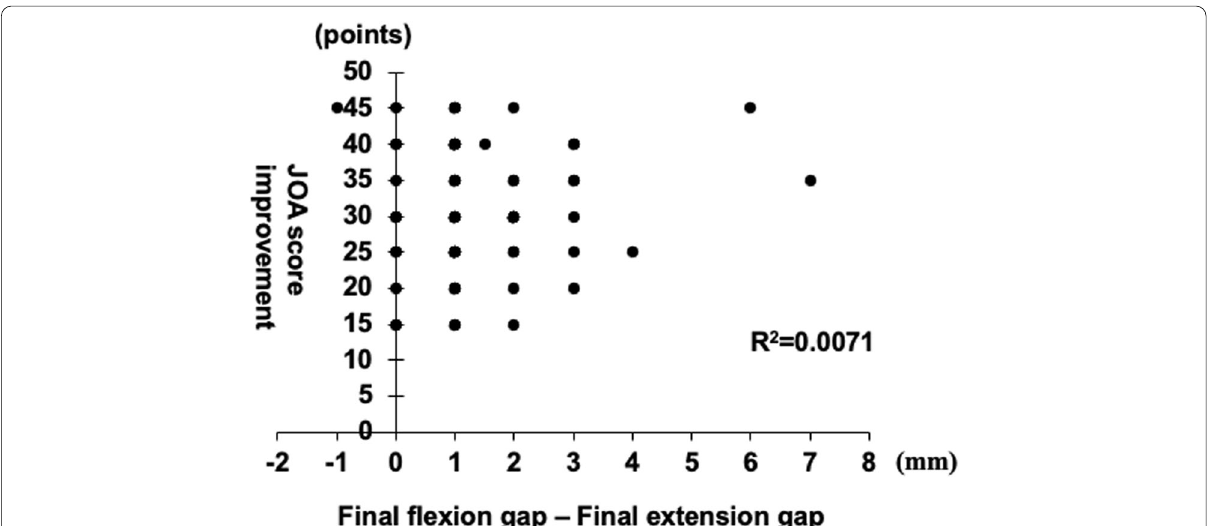
Fig. 7 Clinical outcomes and gap. Relationship between the improvement of the clinical outcomes and gap differences (final flexion CG minus the final extension CG). CG, component